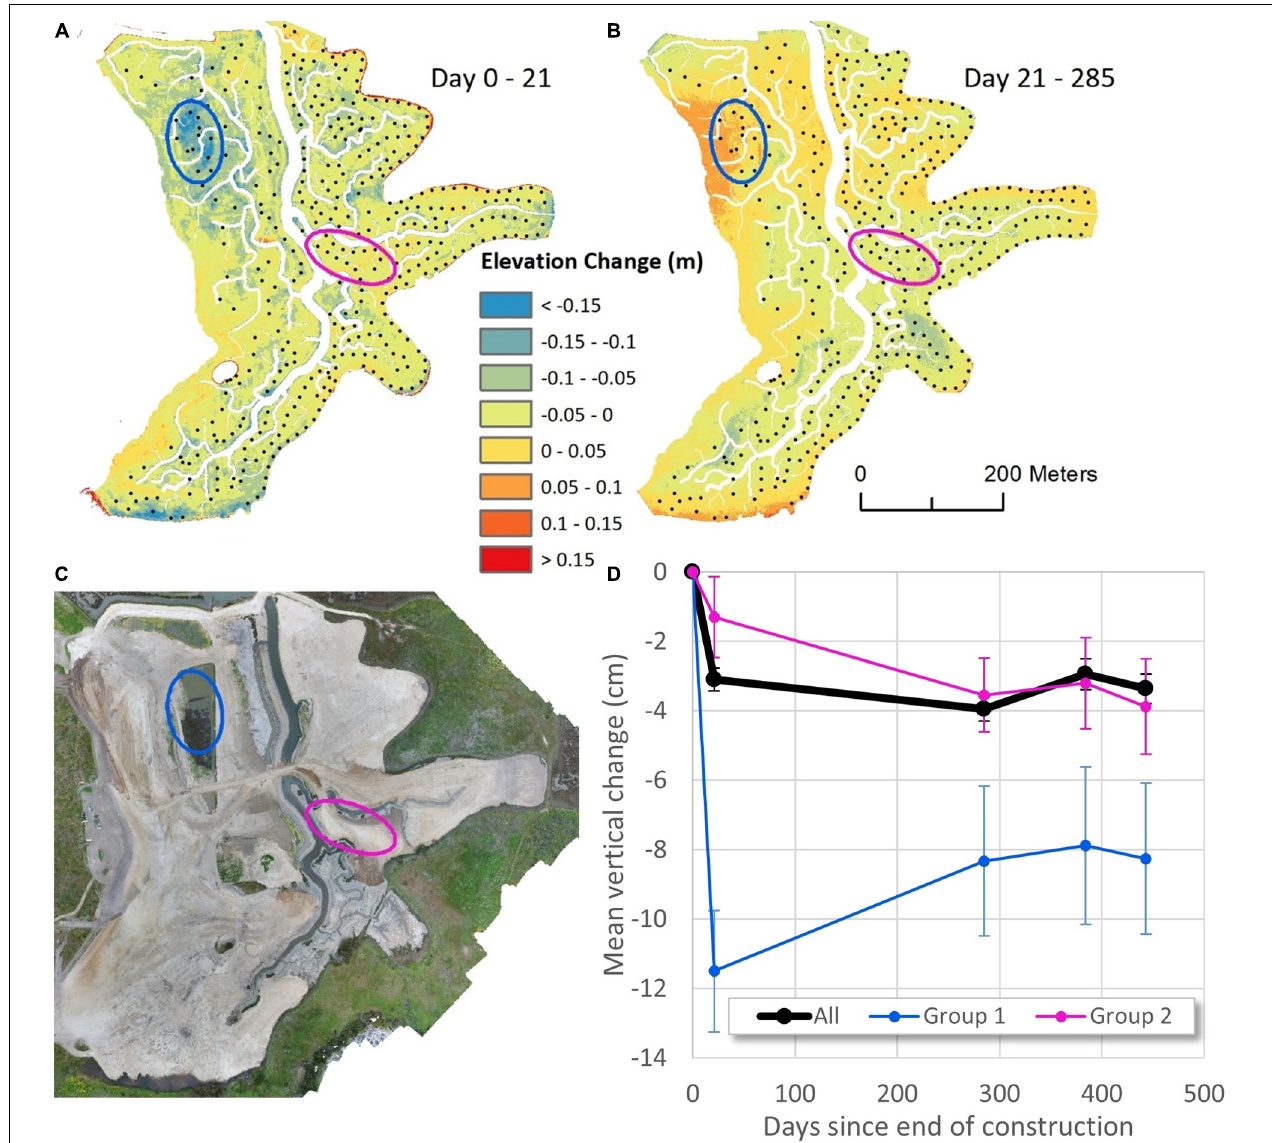
FIGURE 8 | Spatial and temporal patterns of elevation change at Hester Marsh. (A) DoD showing elevation change in the first 21 days following construction, assuming a consistent Day 0 elevation of 1.95 m. Black points show locations of the RTK survey completed at the end of construction in 2018. (B) DoD showing elevation change between Day 21 and Day 285. (C) UAV orthomosaic captured in May 2018 showing an area where excess water was contained during construction (blue oval) and where soil was compacted early on as part of a construction vehicle route (fuchsia oval). (D) Mean difference in original RTK-surveyed elevations and elevation values extracted from four post-construction DEMs at those surveyed positions. The black line represents elevation change at all RTK-surveyed positions, blue line represents the subset of locations within the blue oval in all maps, and fuchsia line represents the subset of locations within the fuchsia oval in all